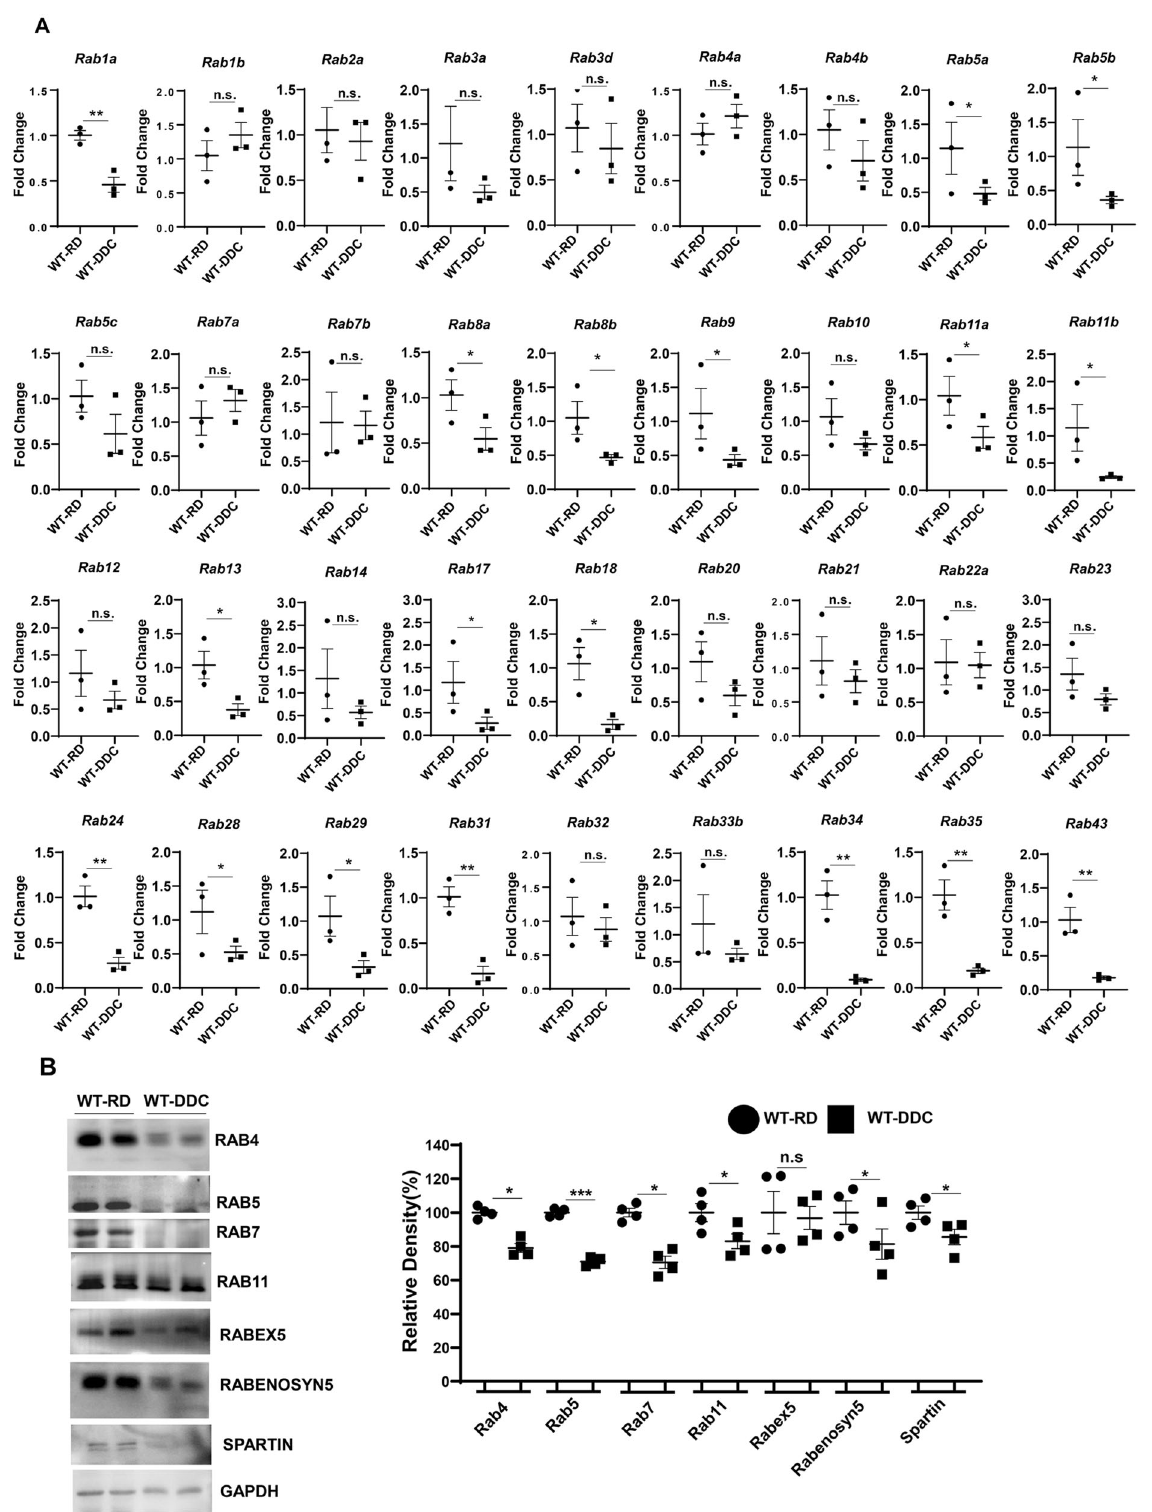
Fig. 5 Inhibition of autophagic fl ux by DDC diet may be due to the downregulation of Rab proteins. A Quantitative PCR analysis for Rab family genes in mRNA expression in wild type mice fed with regular diet (RD), and 2 weeks of DDC diet. The mRNA expression levels were normalized to actin. Data are expressed as the mean±SEM. n.s not signi fi cant, * P ≥ 0.05, ** P ≥ 0.01, *** P ≥ 0.001 ( n = 3). B Total liver lysates were analyzed by immunoblotting for RAB4, RAB5, RAB7, RAB11, RABEX5, RABENOSYN5, SPARTIN and GAPDH proteins. Protein band intensity was normalized to GAPDH band intensity. Data are expressed as the mean±SEM. n.s not signi fi cant, * P ≥ 0.05, *** P ≥ 0.001 ( n = 2).